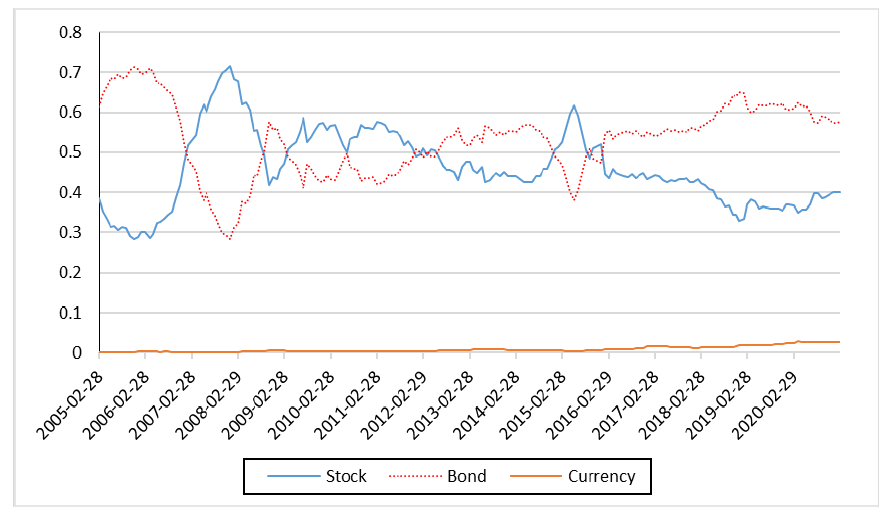
Figure 4. Equilibrium return changes of the three types of assets.